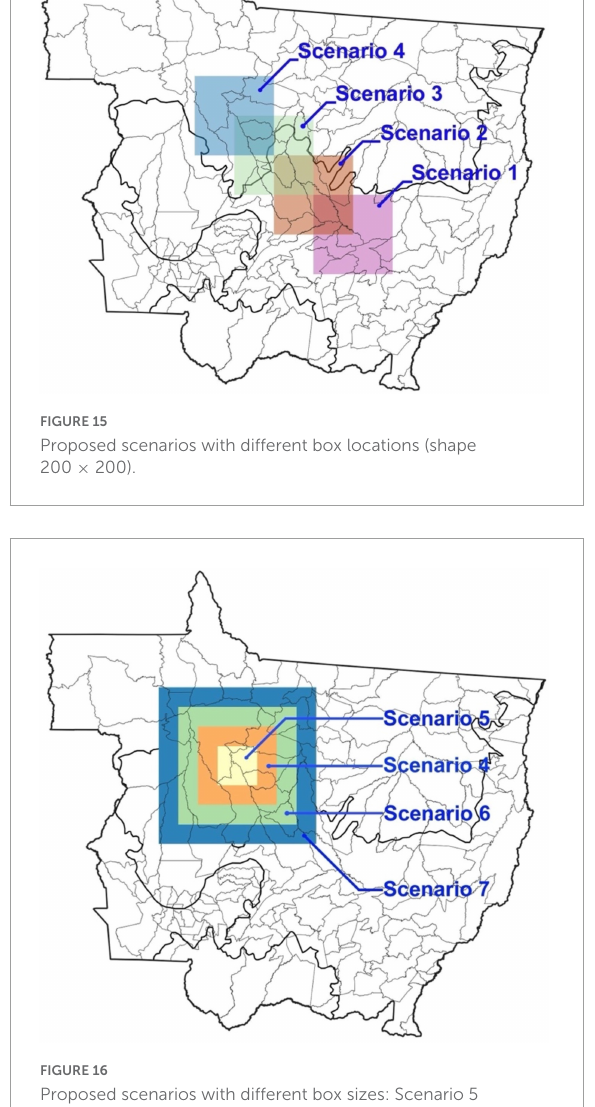
scenarios. The difference between BAU and jurisdictional